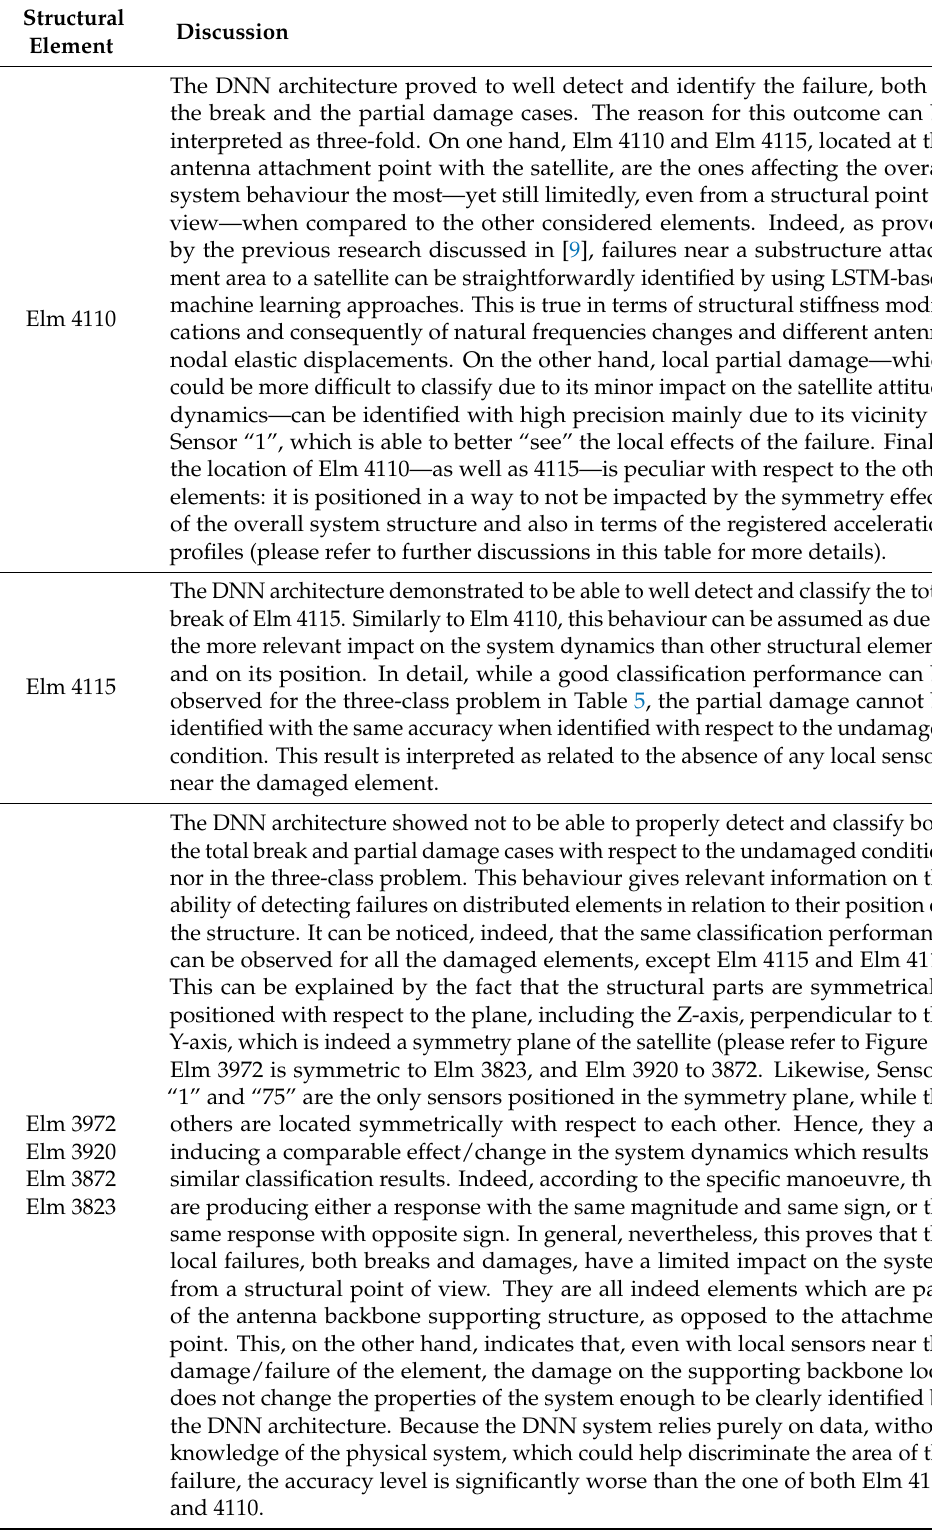
Table 6. Results